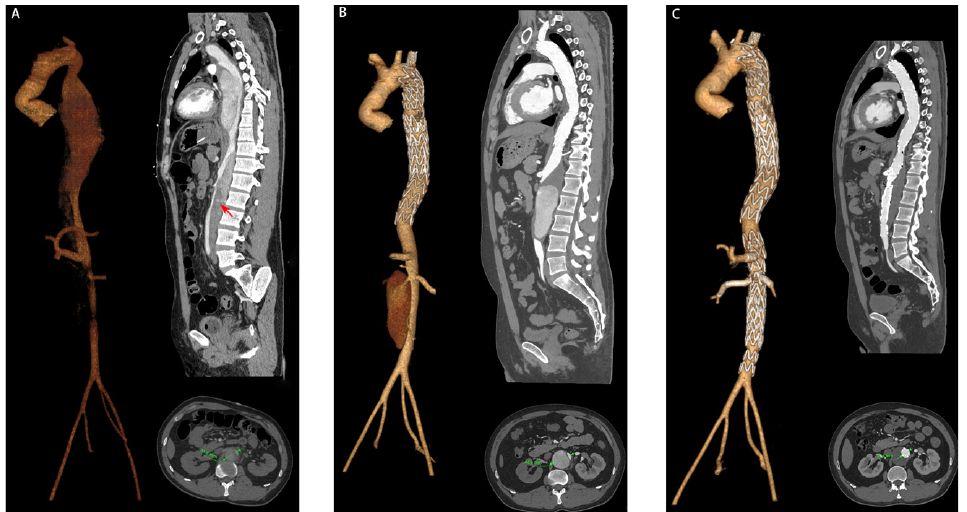
Figure 3. A 43-year-old patient with late aortic expansion at 6 months after TEVAR: ( A ) aortic CTA at onset of symptoms, where the red arrow indicates partial thrombosis of the FL; ( B ) aortic CTA at 6 months after TEVAR and a 12.8 mm increase in aortic diameter compared to the preoperative state; ( C ) aortic CTA at one month after reoperation and complete thrombosis of the FL.